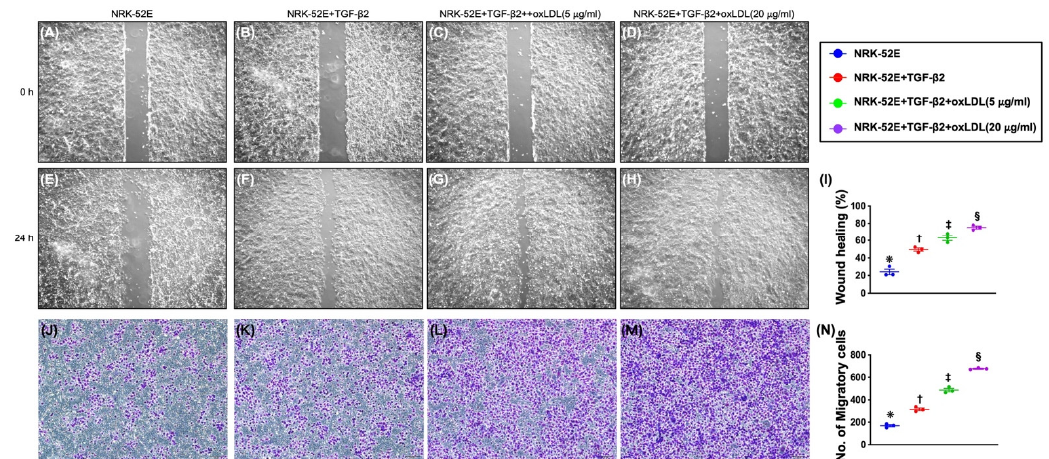
Figure 3. Impact of synergic effect of TGF- β and oxidized LDL on wound healing process and migratory assay of NRK-52E. ( A – D ) Illustrating the baseline (i.e., at 0 h) wound healing process. No difference in term of speed of the wound healing process. ( E – H ) Illustrating the 24 h morphological feature of wound healing process. ( I ) Analytical result of wound healing speed, * vs. other groups with di ff erent symbols (†, ‡, §), p < 0.0001. ( J – M ) Illustrating the microscopic finding (100×) for identification of cell migratory ability (pink-gray color) after 24 h incubation. ( N ) Analytical result of number of migratory cells, * vs. other groups with different symbols (†, ‡, §), p < 0.0001. Scale bars in right lower corner represent 100 μ m. All statistical analyses were performed by one-way ANOVA, followed by Bonferroni multiple comparison post hoc test (n = 5 for each group). Symbols (*, †, ‡, §) indicate significance for each other (at 0.05 level).